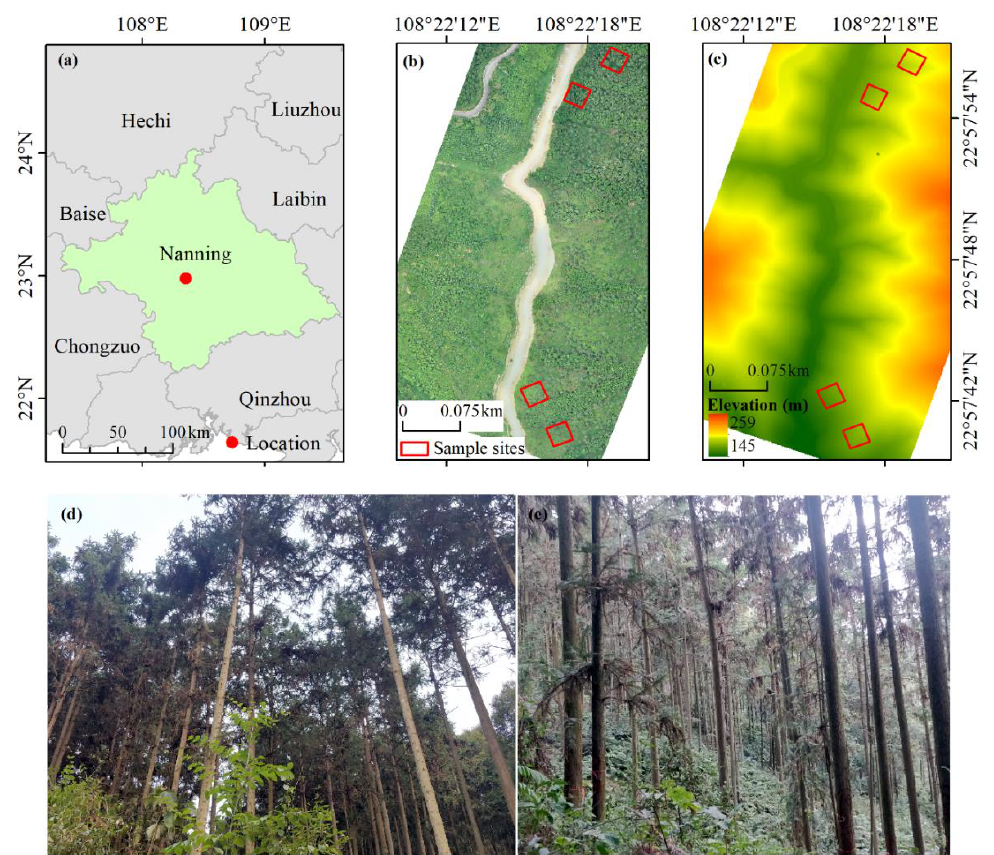
Figure 1. Overview of the study area. ( a ) Location of study area; ( b ) Digital orthophoto model (DOM) and distribution of sample sites; ( c ) Digital elevation model (DEM). ( d , e ) are ground photographs of the sample plots and trees.